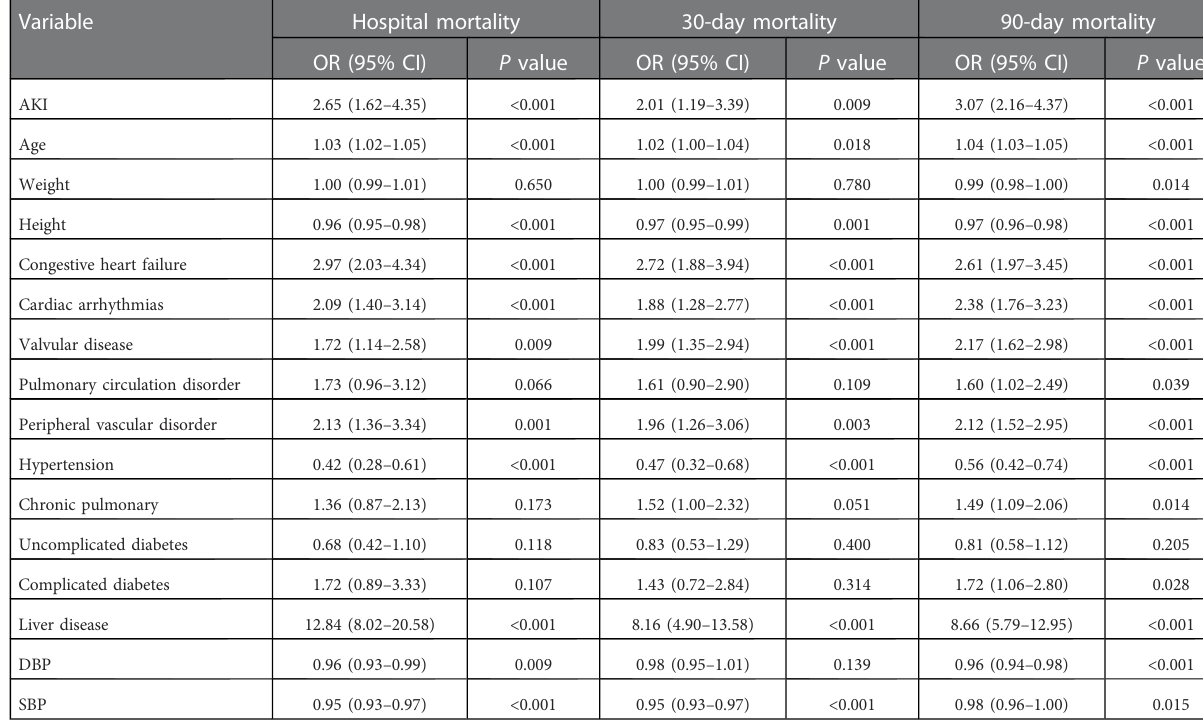
TABLE 3 Univariate logistic regression analyses for prognosis in cardiac surgery patients.